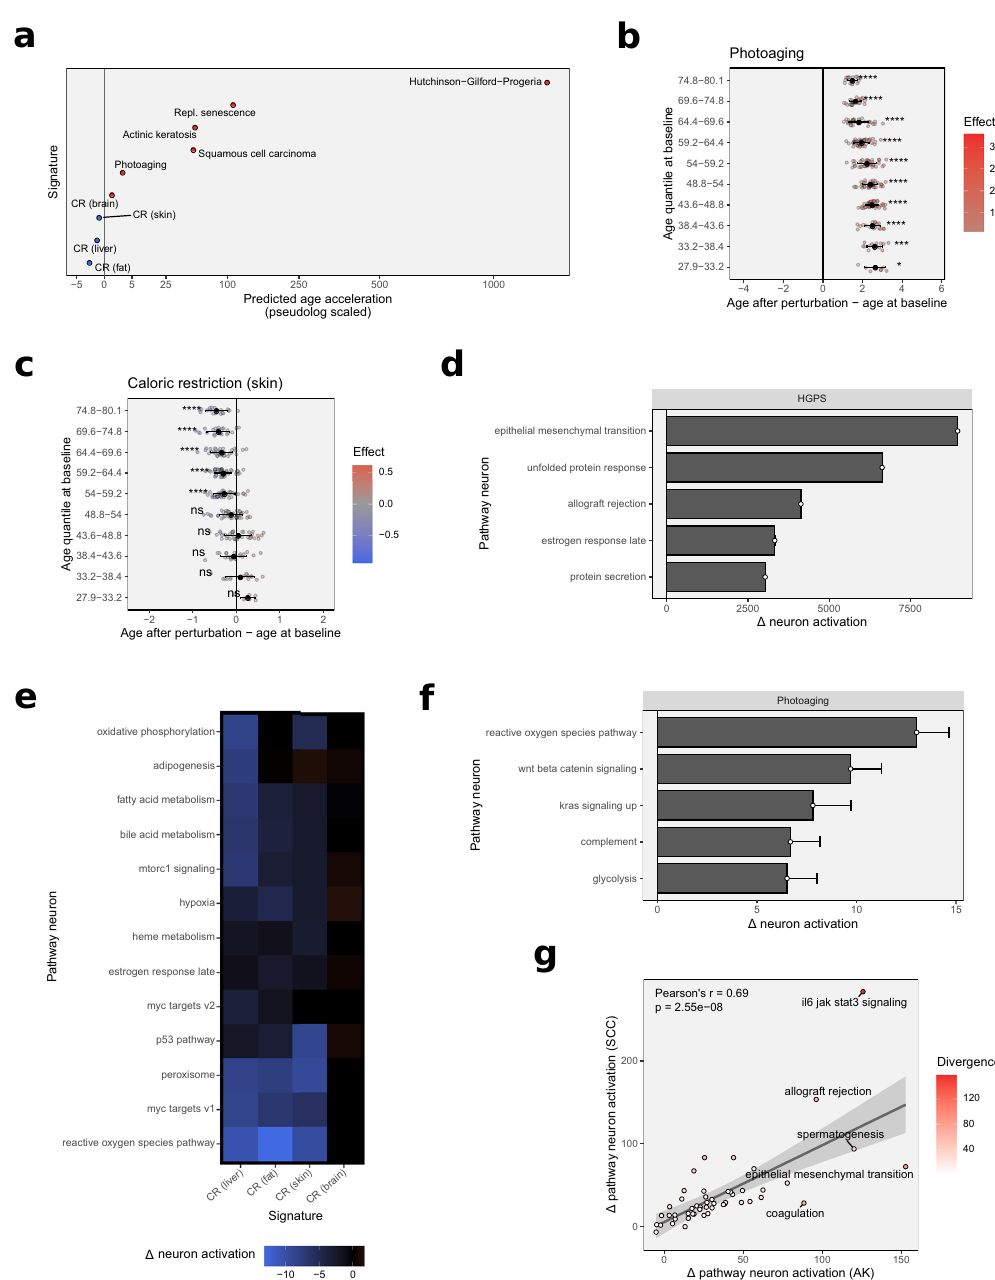
Fig. 4 Assessing the impact of age- and disease-related gene expression signatures on transcriptomic age and pathway aging states. a Overview of the average predicted effect of the transcriptomic perturbation using multiple age- and disease-related signatures. b Predicted effect of the transcriptomic perturbation using a signature of chronically sun-exposed skin, strati fi ed by chronological age quantiles. Signi fi cance was determined using one-sample Wilcoxon rank-sum tests, testing for the difference in medians from an effect size of 0, with p -values adjusted for multiple testing. Error bars show standard deviations. c Predicted effect of the transcriptomic perturbation using a caloric restriction signature, strati fi ed by chronological age quantiles. Signi fi cance was determined using one-sample Wilcoxon rank-sum tests, testing for the difference in medians from an effect size of 0, with p -values adjusted for multiple testing. Error bars show standard deviations. d Effect of the transcriptional signature of Hutchinson – Gilford progeria syndrome on pathway neuron activation. Shown are the fi ve most strongly affected pathways. Error bars show standard deviations. e Heatmap showing the effects of tissue-speci fi c caloric restriction signatures on pathway neuron activation. f Effect of the transcriptional signature of photoaging on pathway neuron activation. Shown are the fi ve most strongly affected pathways. Error bars show standard deviations. g Impact of actinic keratosis (AK) and cutaneous squamous cell carcinoma (SCC) signatures on pathway neuron